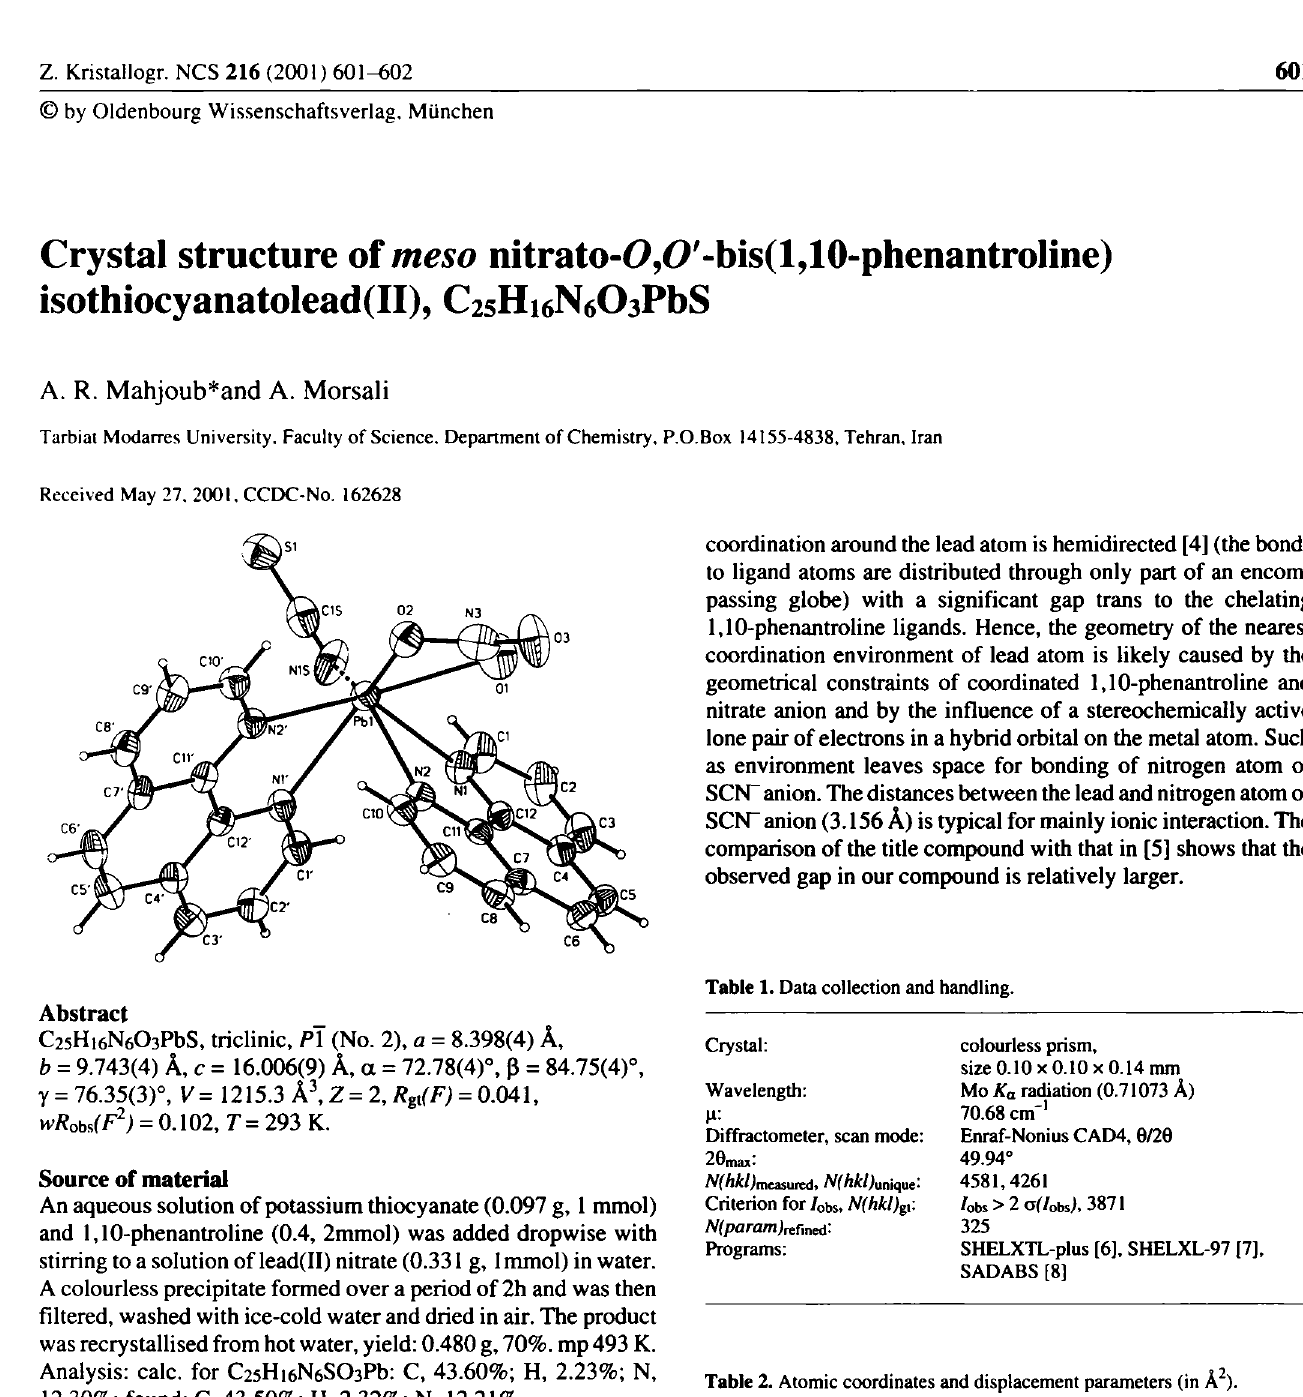
Table 2. Atomic coordinates and displacement parameters (in A 2